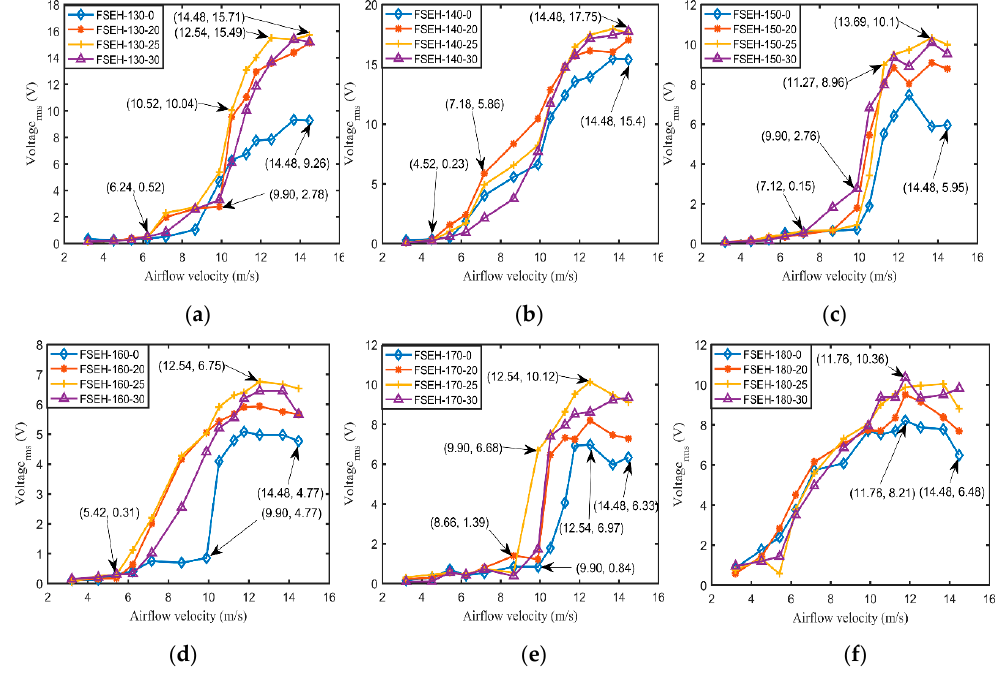
Figure 9. Variation of output voltage with airflow velocity for various harvesters with different flexible spring length: ( a ) 130 mm; ( b ) 140 mm; ( c ) 150 mm; ( d ) 160 mm; ( e ) 170 mm; and ( f ) 180 mm.